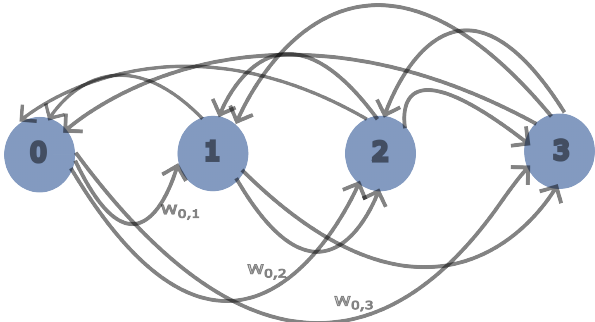
Figure 3. Directed graph